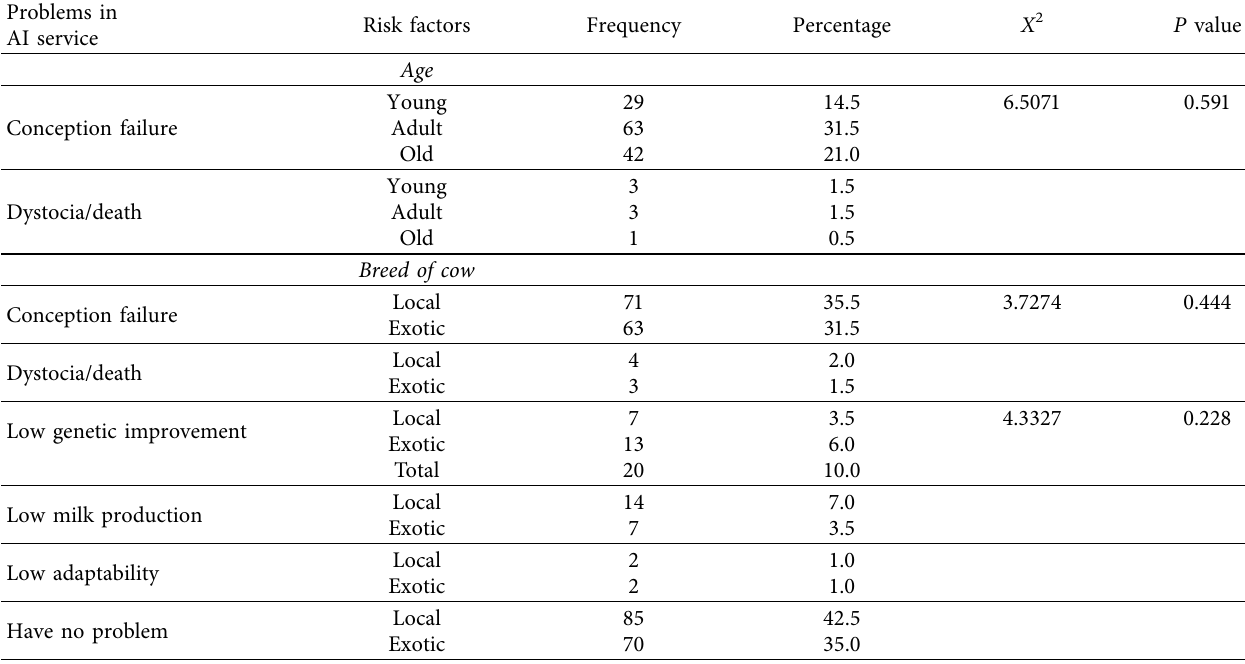
Table 5: Association of problems of AI service concerning age and breed of cattle.